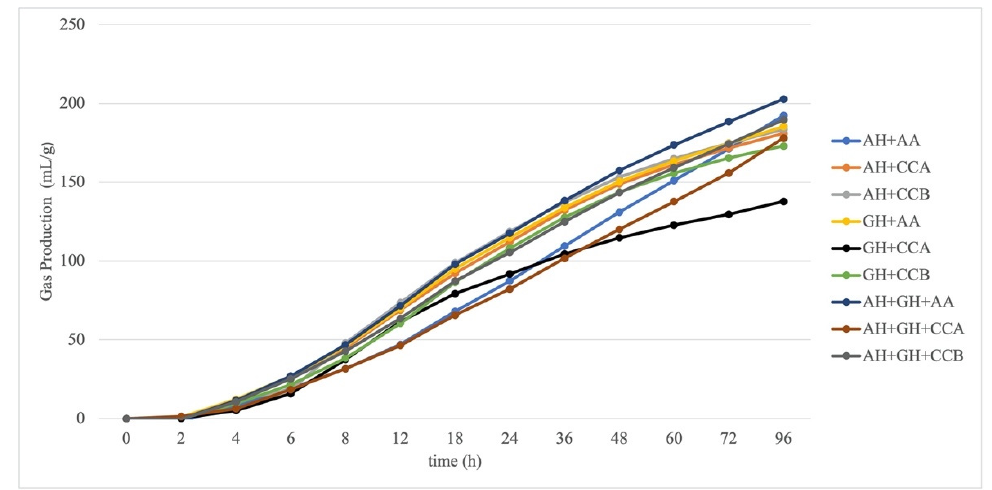
Figure 2. In vitro gas production kinetics of the experimental diets. AH: alfalfa hay, CCA: starch- based commercial concentrate, CCB: commercial concentrate with soluble fiber sources, GH: grass hay; O-WM: 50% oats and 50% wheat middlings. In vitro GP parameters (A, 96GP, k, c and MDR) were affected by a forage/concentrate interaction ( p < 0.001). When mixed with AH, CCA and CCB showed a similar A and was lower than O-WM, whereas CCA had a lower A compared to CCB and O-WM when mixed with GH; finally, CCA had a greater A than CCB and O-WM when mixed with AH and GH. For 96GP, there were no differences between concentrates when mixed with AH and AH-GH, whereas a greater GP was observed for CCB and O-WM when compared to CCA. Fermentation rate parameters (c and MDR) were greater for CCA and CCB when mixed with AH and GH; however, when mixed with AH-GH, it was reduced for CCA and was greater for CCB and O-WM. This resulted in a longer k for O-WM when mixed with AH, and this was similar among the different types of concentrates with GH and was longer for CCA with AH-GH (Table 3). Table 3. Forage concentrate interaction and associative effects for in vitro gas production parameters and concentration of volatile fatty acids produced. Alfalfa Hay Grass Hay 50% Alfalfa Hay–50% Grass Hay